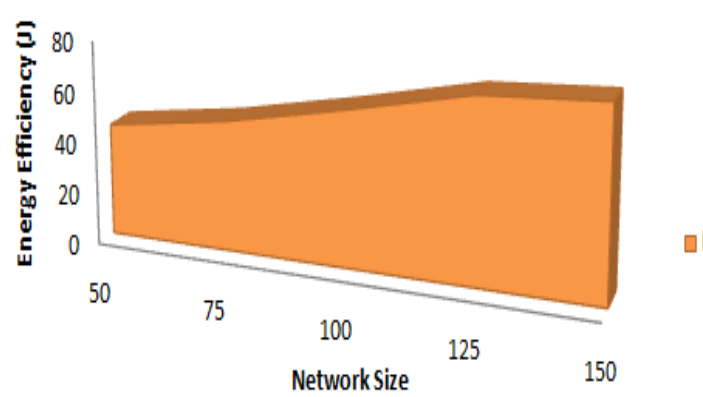
Figure 7. Energy efficiency of MLRP-HTEEN-UDSP.